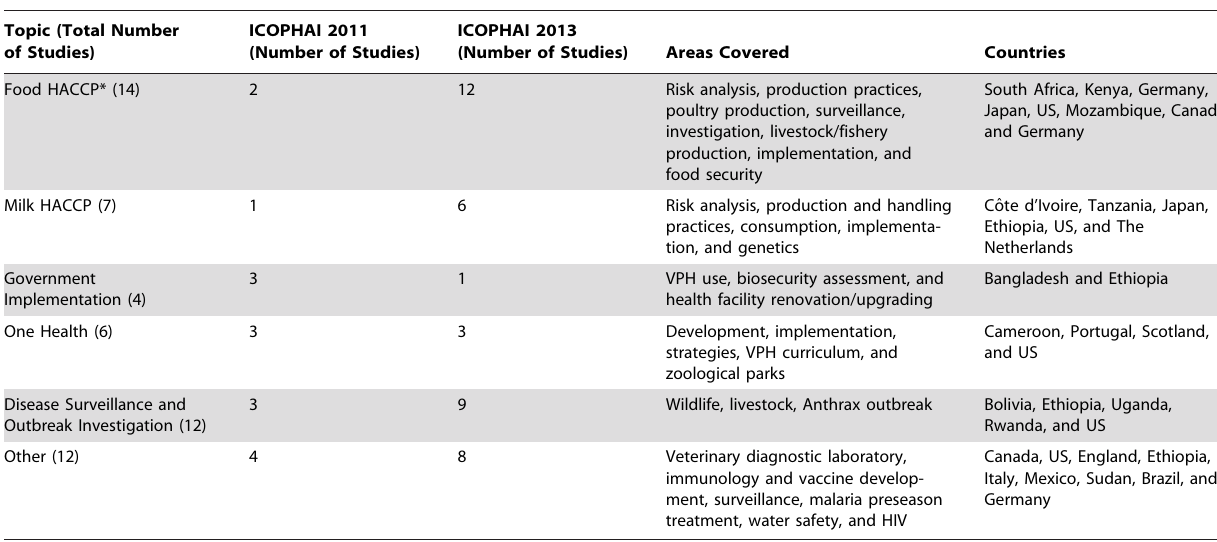
Table 1. Summary of capacity building issues and origins of the studies reported at ICOPHAI.